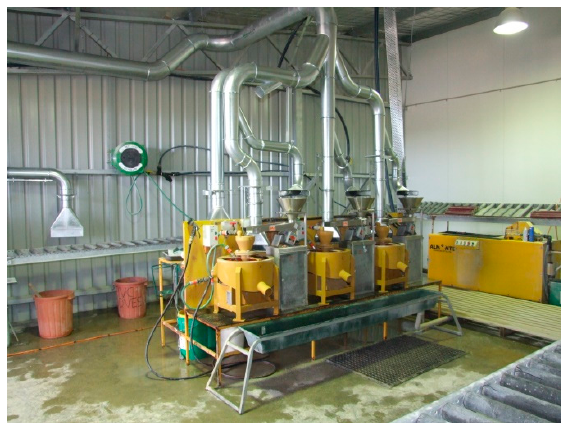
Figure 3. LGL gravity concentrator facility.